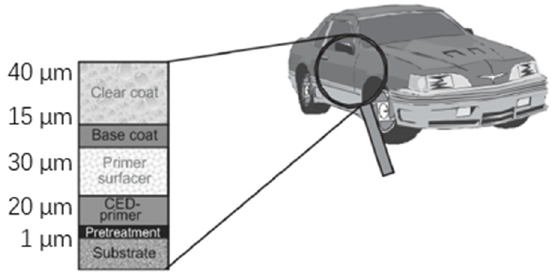
Figure 11. The automotive body coating construction.